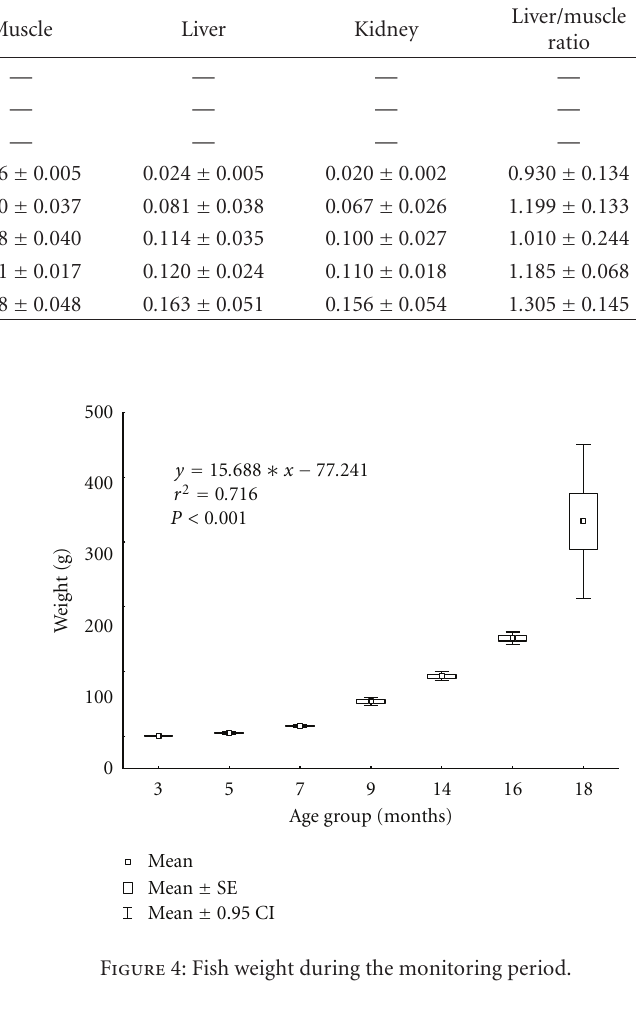
Figure 5). Kidney mercury concentrations di ff ered signif- icantly from muscle and liver mercury concentrations ( t -test: muscle—kidney: t = 6 . 474, df = 9, P < 0 . 001; liver—kidney: t = 4 . 548, df = 9, P = 0 . 001; Figure 5). Muscle and liver mercury concentrations in fish